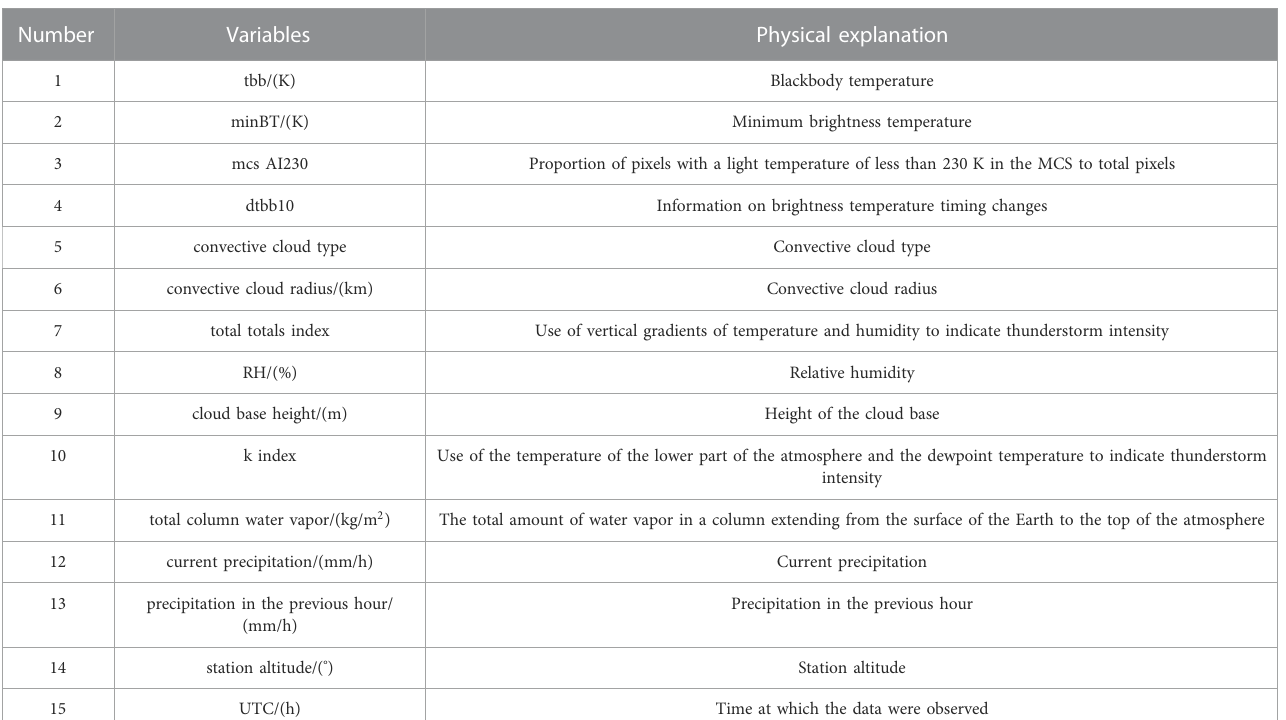
TABLE 1 Input variables for the random forest